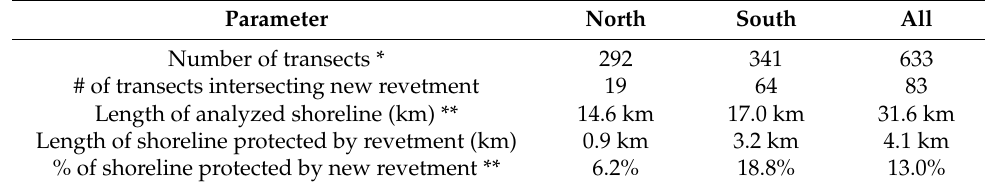
Figure 4. Example of transects at 50 m increments used for Digital Shoreline Analysis System (DSAS) shoreline change analysis; Normalized Difference Water Index (NDWI) from a 6 January 2019 PlanetScope image (3.7 m pixel) [48] in background; black indicates water; white shoreline strip is Revetment B in Ramgati Upazila; green line is 2011 shoreline; red line is 2019 shoreline. Table 5. Transect and shoreline parameters used for shoreline change analysis.